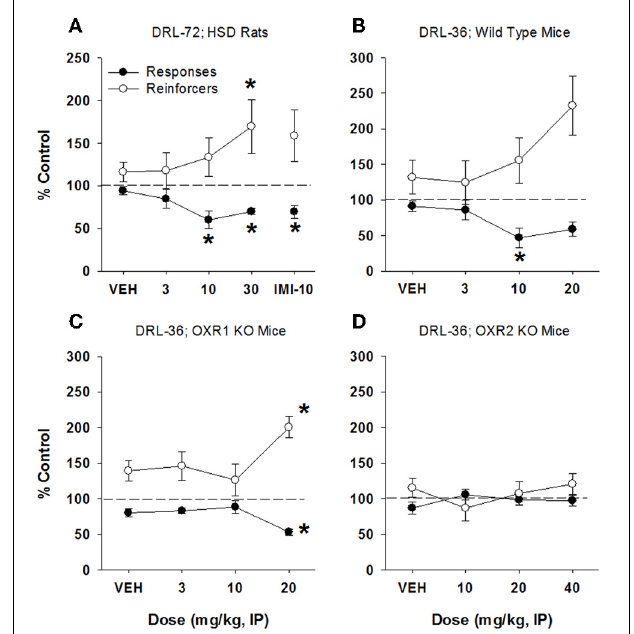
FIGURE 6 | Antidepressant-like effects of LSN2424100 on DRL-72-s responding in rats and DRL-36-s responding in mice. (A) dose-dependent increase in the number of reinforcers obtained by male SD rats in DRL-72-s ( n = 7), with a significant effect at 30mg/kg ( p < 0 . 05) and a significant decrease in total responses emitted at 10 and 30mg/kg ( p < 0 . 05); (B) a significant decrease in total responses emitted by C57Bl/6 mice in DRL-36-s at 10mg/kg ( p < 0 . 05; n = 8); (C) antidepressant-like efficacy of LSN2424100 is maintained in mice lacking OX1 receptors, with a significant increase in reinforcers obtained and a significant decrease in responses at 20mg/kg ( p < 0 . 05; n = 8); (D) antidepressant-like effect of LSN2424100 is lost in mice lacking OX2 receptors, as illustrated by lack of significant effects in either responses emitted or reinforcers received at all doses ( n = 8). ∗ p < 0 . 05 vs. respective vehicle, Dunnett’s post-hoc